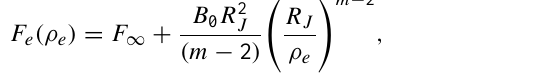
a very narrow co-latitude range. This is shown explicitly in Fig. 4c, where we plot the co-latitude of the field lines in the ionosphere versus equatorial radial distance. In the current sheet model (solid line), the ionospheric mapping varies from a co-latitude of ∼ 16.7 ◦ at 30 R J to ∼ 15.6 ◦ at 120 R J , a range of only ∼ 1.1 ◦ . Even the current sheet field line from infinity, should the model (unrealistically) be taken to extend that far, only maps to ∼ 15.0 ◦ . Field lines at smaller co-latitudes